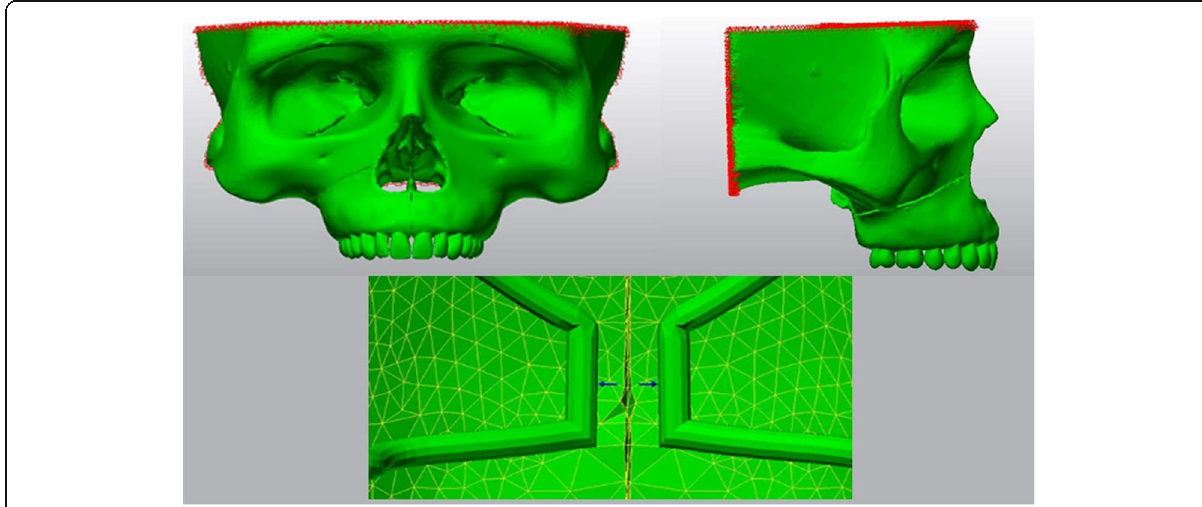
Fig. 5 The skull model was fixed over the supraorbital region and from the posterior plane. (above left and right) The blue arrows in opposing directions show the center of force application through the mid-palatal suture